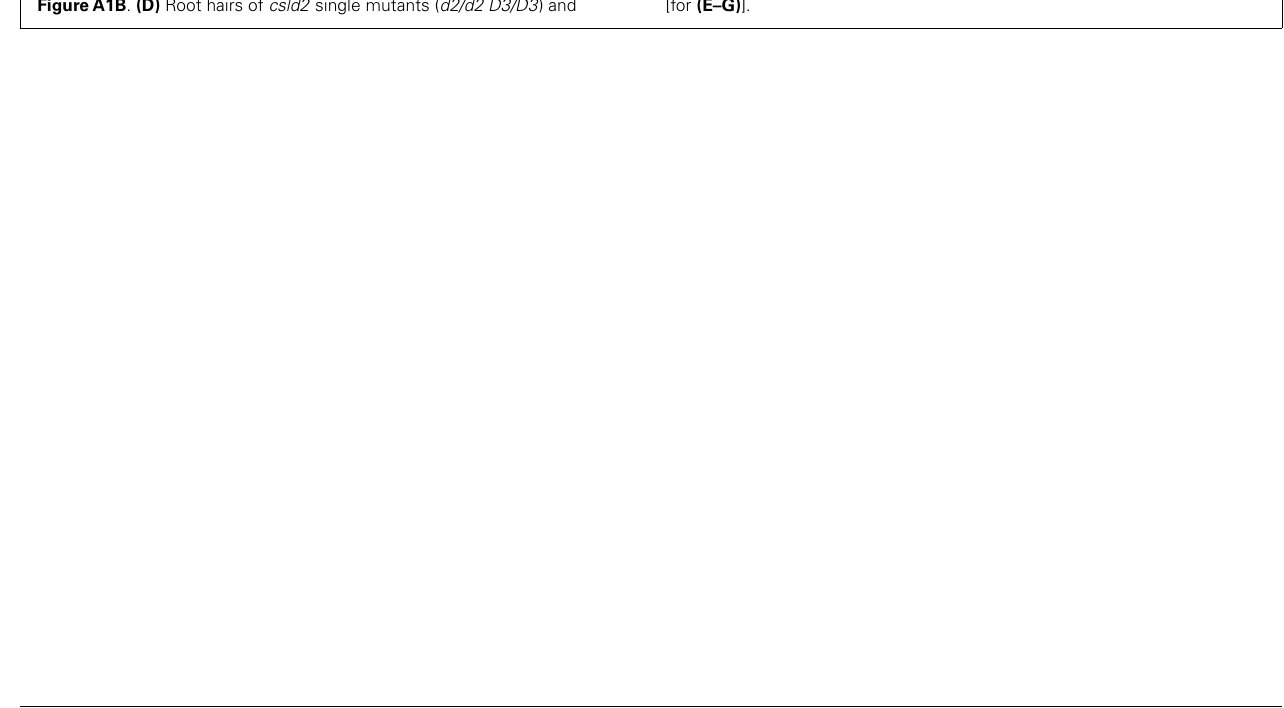
FIGUREA2 | Complementation of csld2 csld3 double mutants. (A,E) Are wild-type, (B,F) are csld2 csld3, and (C,G) are the complemented line ( csld2 csld3 w/ CSLD3 ) as validated by the genotyping experiments shown in FigureA1B . (D) Root hairs of csld2 single mutants ( d2/d2 D3/D3 ) and